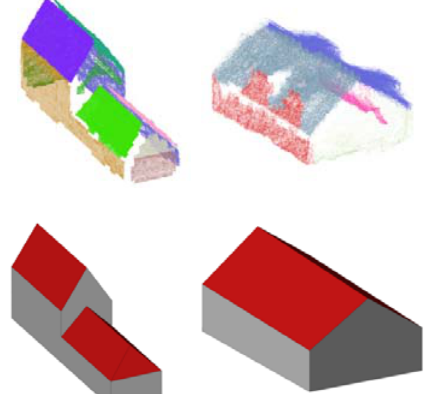
Figure 2. Merged groups (top) and reconstructed result